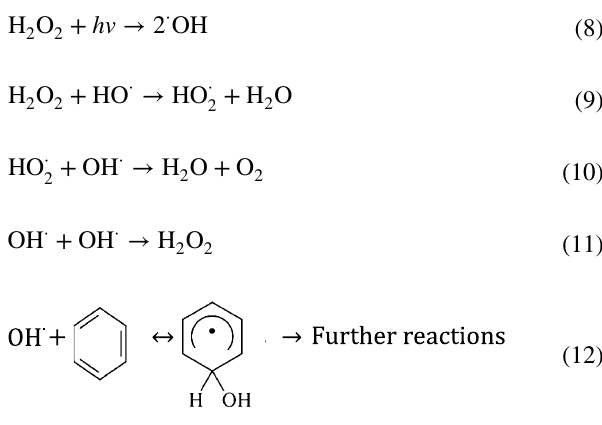
Fig. 6 Effect of operating parameters on Mn 0.6 Zn 0.4 Fe 2 O 4 /H 2 O 2 / UV system: Effect of catalyst (H 2 O 2 400 mg L −1 , pH 3.0) on ( a ) col- our and ( b ) COD removals; Effect of H 2 O 2 (Catalyst 40 mg L 1 , pH 3.0) on ( a ) colour and ( b ) COD removals; ( c ) Effect of pH